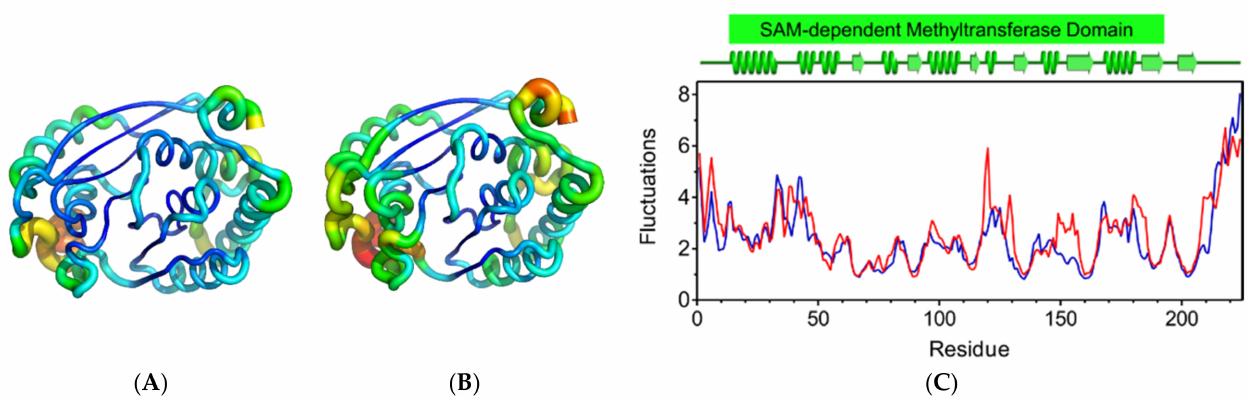
Figure 4. Analysis of atomic fluctuations. Cartoon putty representations of Mt GidB structures: ( A ) wild-type (WT, L101) and ( B ) mutant (MU, F101). Blue represents the lowest value for B-factor and red the highest. The size of the tube reflects the value of the B-factor (i.e., the larger the B-factor, the thicker the tube). ( C ) A plot of the residue-based fluctuations (Å) estimated for WT (blue) and MU (red). The predicted secondary structure ( α -helices and β -strands) for Mt GidB and the stretch corresponding to its SAM-MTase domain are colored green (PDB representation, top